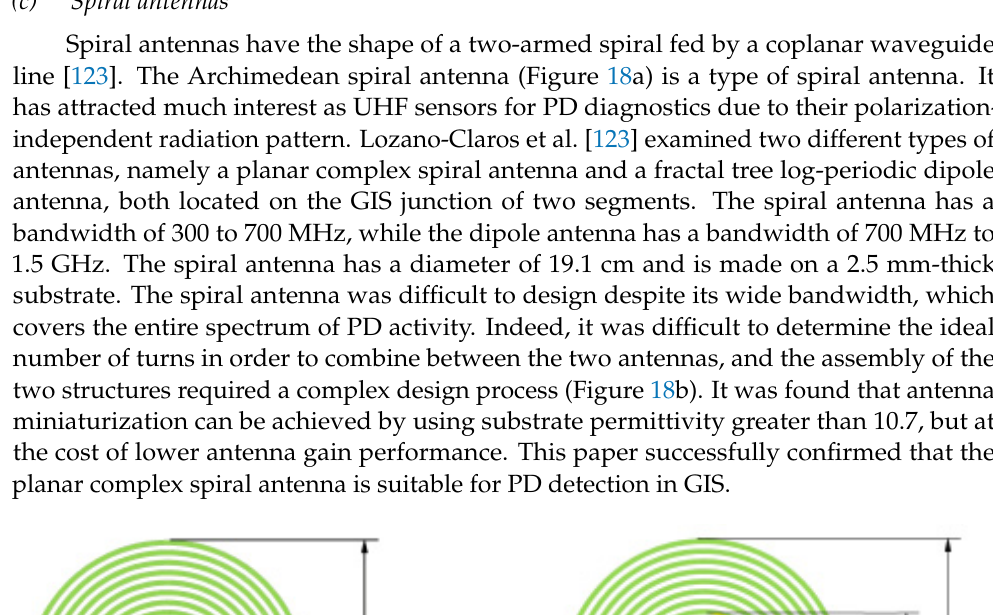
Figure 17. Microstrip antennas: ( a ) the circularly printed monopole antenna studied in [118], ( b ) the bio ‐ inspired antenna based on the Inga Marginata studied in [119], ( c ) the UWB ‐ printed antenna with a modified U ‐ shaped proposed and studied in [120], and ( d ) the circular ‐ shaped microstrip patch antenna studied in [122].